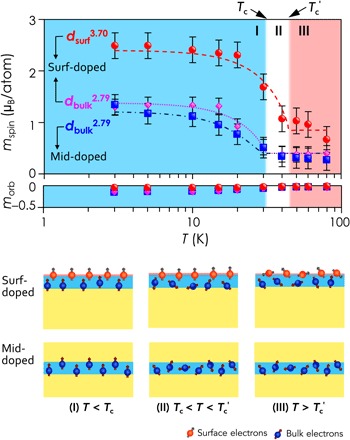
M-T relationships.(Top)The XAS/XMCD-derived mspin and morb of the dsurf3.70 and dbulk2.79 versus temperature (T) at 3 to 80 K of the modulation-doped Bi2Se3 thin films. The dashed lines are the best fit within the mean-field approximation. (Bottom) Schematic illustration of the three-step transition: Both the surface and bulk are magnetically ordered below Tc (phase I); between Tc and Tc′, the surface retains magnetization while the bulk does not anymore (phase II); eventually, beyond Tc′, both the surface and bulk lose their magnetic orders (phase III).